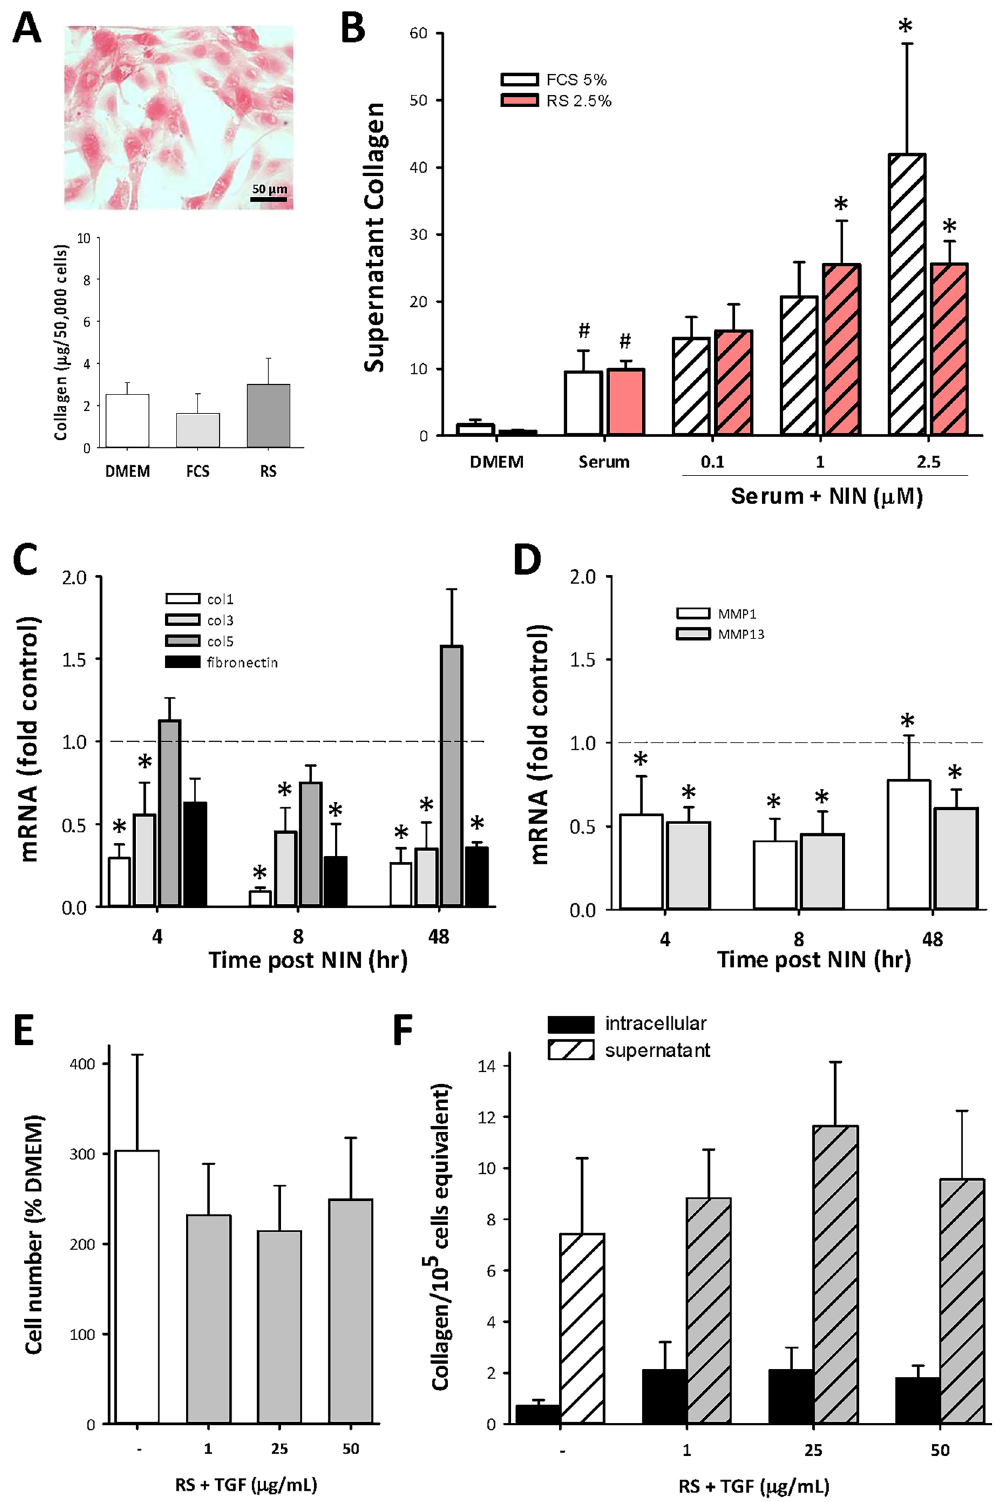
Figure 5. NIN regulates extracellular matrix protein expression in high-passage CSMC. ( A , B ) Determination of collagen levels by SirCol quantitative assay. ( A ) Example of histology of Sirius Red staining of serum-stimulated CSMC (top; scale bar, 50 µm) and intracellular collagen levels in CSMC in serum-free (DMEM) or serum-treated conditions. ( B ) Increased supernatant collagen in CSMC cultures with serum or serum + NIN treatment. # p < 0.05 vs DMEM; *p < 0.05 vs serum alone. ( C , D ) Quantitative PCR analysis of mRNA for collagen I, III and V, fibronectin ( C ) or metalloproteinases ( D ; MMP1 and MMP13). CSMC were treated with FCS + NIN (1 µM) for 4, 8 or 48 h and data expressed relative to untreated controls. *p < 0.05 vs untreated control. ( E , F ) Absence of effect of TGFβ (1–50 ng/mL, 48 h) on CSMC growth ( E ) or total intracellular or secreted collagen ( F